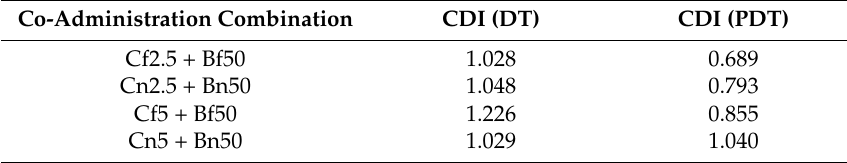
Table 4. Determining the Coefficient of Drug Interaction with Co-Administration of BPD and